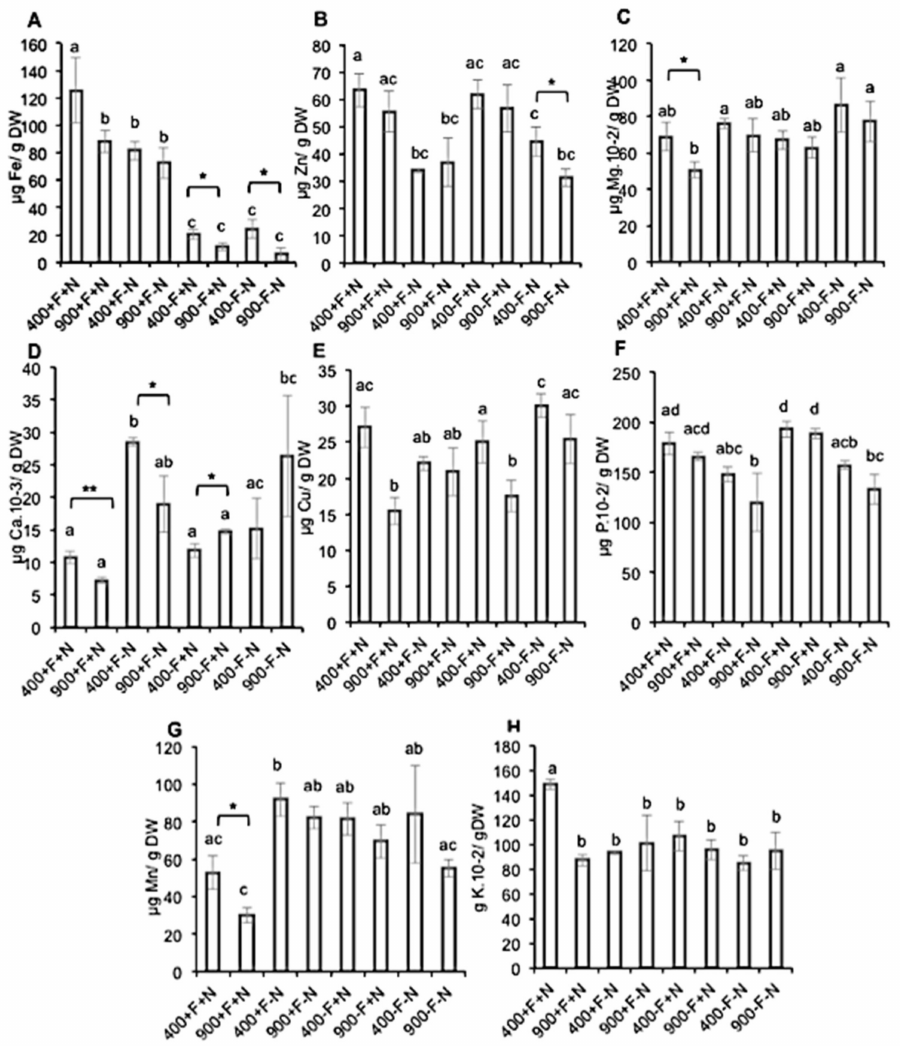
Figure 2. Mineral nutrient content of Micro-Tom tomato fruits. Fruit samples were collected from hydroponically grown plants under ambient (400 ppm) or elevated (900 ppm) atmospheric CO 2 concentrations with four nutritional regimes: control (+F/+N), iron deficiency ( − F/+N), nitrogen deficiency (+F/ − N) or dual deficiency ( − F/ − N). ( A ) Iron, ( B ) Zinc, ( C ) Magnesium, ( D ) Calcium, ( E ) Copper, ( F ) Phosphorus, ( G ) Manganese, ( H ) Potassium. Error bars show ± SD ( n = 3). T -test significance: *, p < 0.05; **, p < 0.01. Means within each condition with the same letter are not statistically different according to one-way ANOVA followed by post hoc Tukey test ( p <